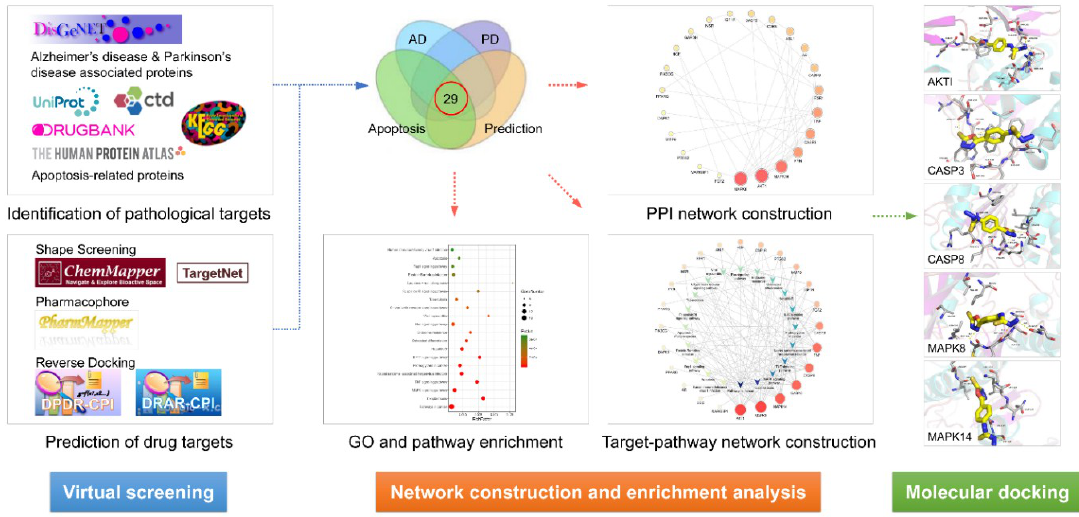
Figure 6. The experimental flow of this study. AD, Alzheimer’s disease; PD, Parkinson’s disease; PPI, protein–protein interaction; GO, gene ontology.